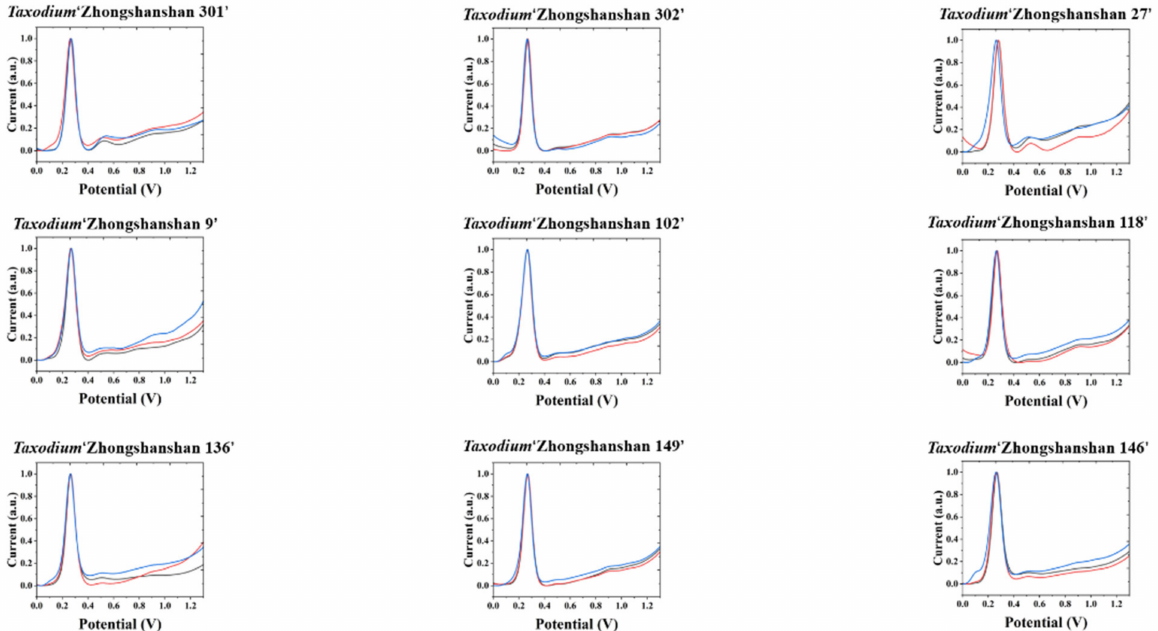
Figure 2. Electrochemical fingerprint of T. ‘Zhongshanshan 301’, T. ‘Zhongshanshan 302’, T. ‘Zhongshanshan 27’, T. ‘Zhongshanshan 9’, T. ‘Zhongshanshan 102’, T. ‘Zhongshanshan 118’, T. ‘Zhongshanshan 136’, T. ‘Zhongshanshan 125’, and T. ‘Zhongshanshan 146’ after water extraction and recorded under PBS